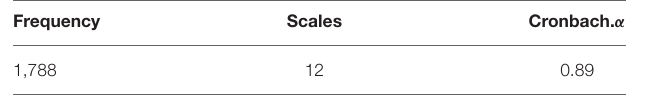
TABLE 2 | Reliability test.